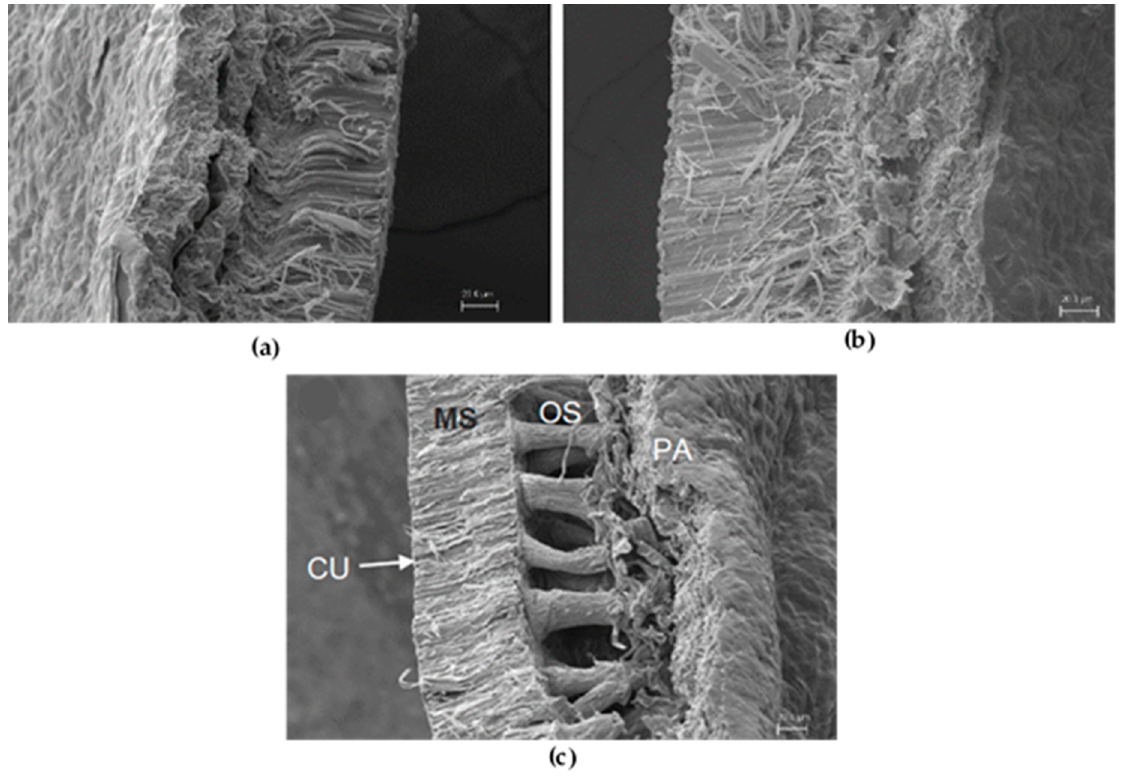
Figure 3. Scanning electron microscopy of Lupinus seeds coat of different varieties: ( a ) L. albus ; ( b ) L. angustifolius ; ( c ) L. mutabilis . CU-cuticle; MS-macrosclereids layer; OS-osteosclereid layer; PA-parenchymal cells.